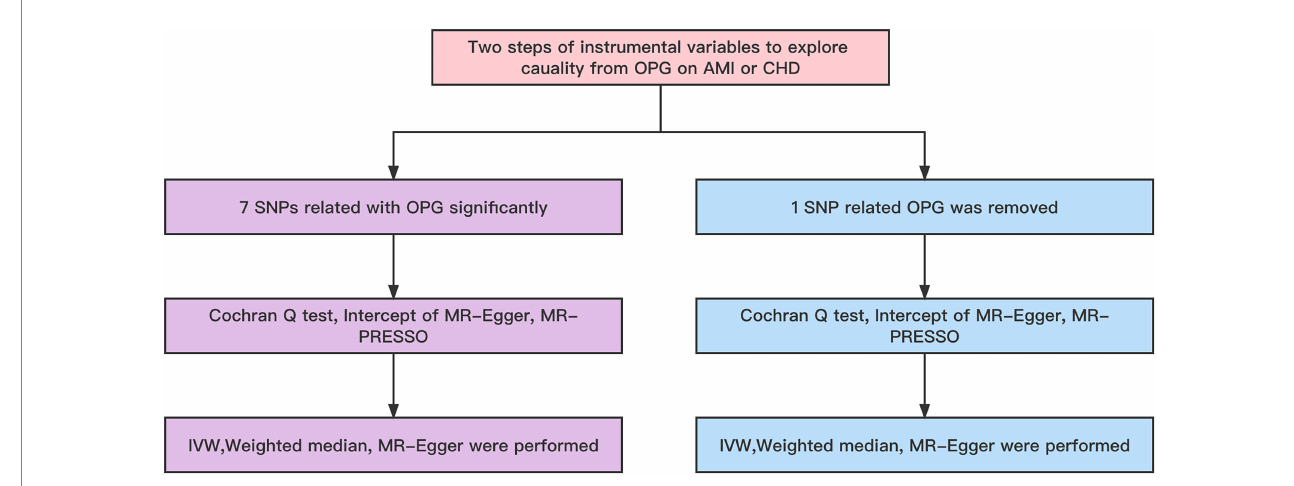
FIGURE 2 Workflow of MR. IVW, Inverse variance weighted; MR Pleiotropy RESidual Sum and Outlier; SNP, single-nucleotide